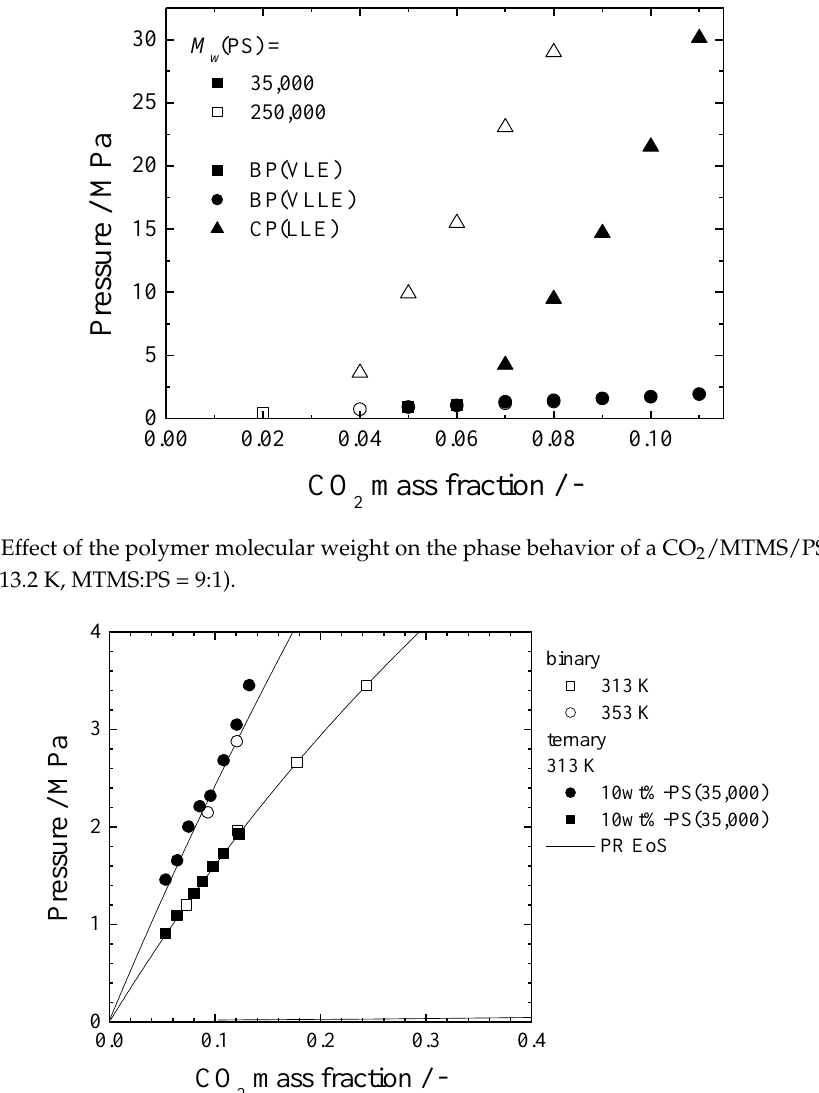
Figure 3. Comparison between CO 2 /MTMS/PS (M W = 35,000) ternary and CO 2 /MTMS binary systems.